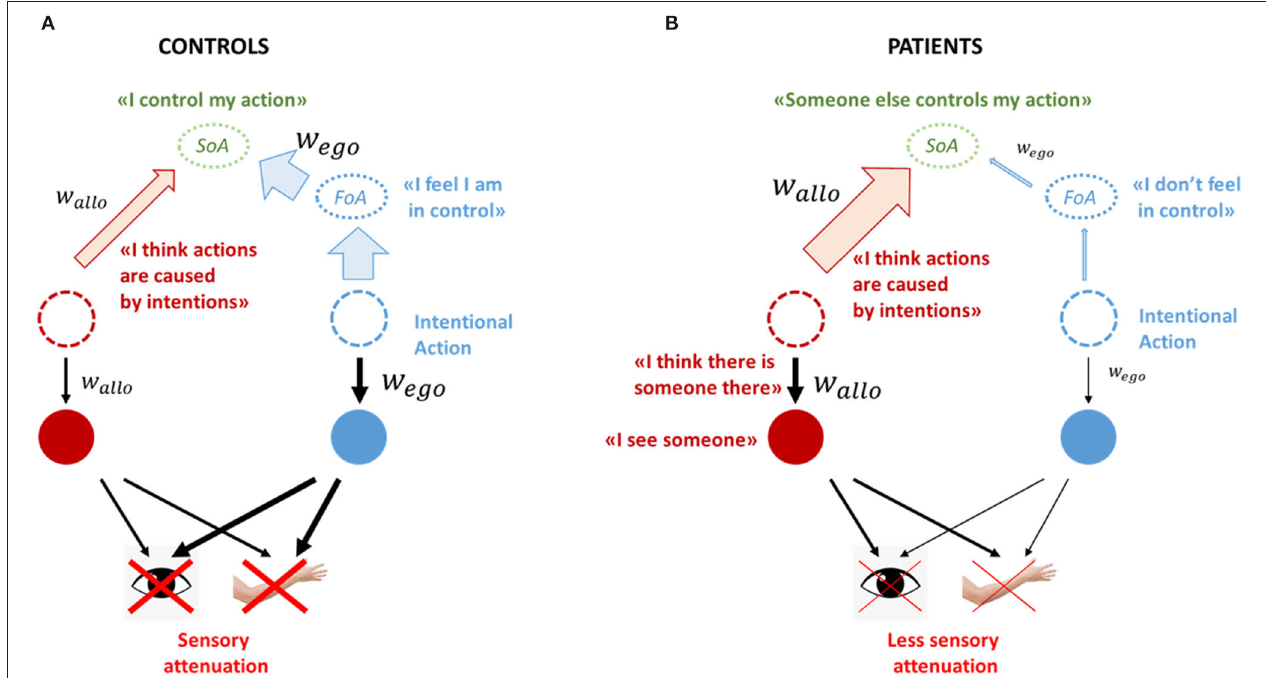
FIGURE 2 | Healthy controls vs. Schizophrenia patients. (A) In a well-functioning system, predictions (both ego-centric and allo-centric) are weighted according to their reliability. When an intentional action is initiated, strong corollary discharge signals explain-away self-generated inputs, which in turn give rise to a FoA and a sense that one is in control of their actions. Within the allo-centric system, that results in optimal perceptual inferences (B) When motor predictions are under-weighted (e.g., in schizophrenia), self-generated inputs cannot be explained away, resulting in a feeling that one is not in control of their actions. The unsuppressed inputs flood into the allo-centric system, which is overflowed with noisy and inherently unpredictable information. To compensate for that, it increases the weight of high level allo-centric priors, including agency-related priors such as the intentionality bias. Strong priors have an effect both on perceptual decision making and on agency-attribution: first, percepts are mainly driven by priors, rendering the system susceptible to hallucinations. Second, the enhanced intentionality bias, combined with the lack of a FoA, bring about the false belief that an external agent is in control of one’s own actions, i.e., a delusion of